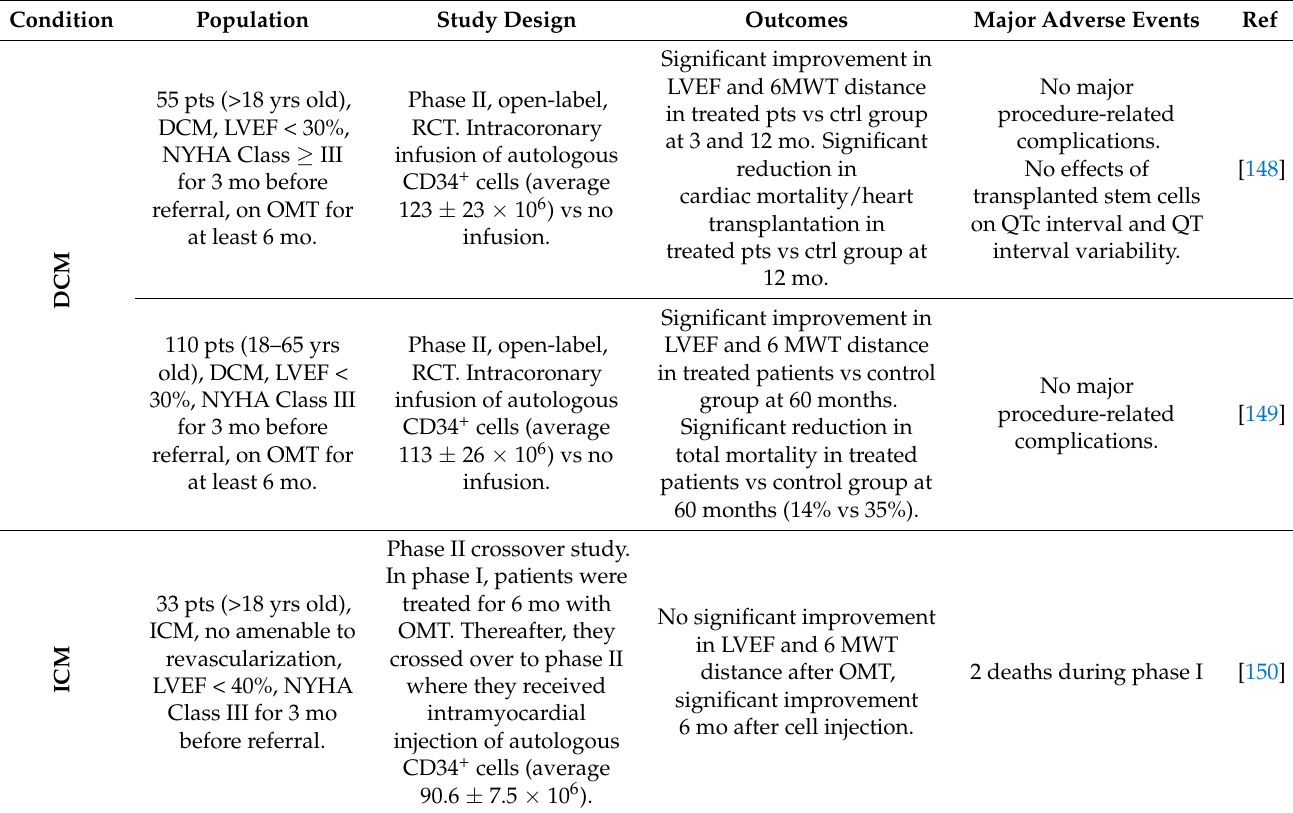
Table 2. Clinical trials on dilated and ischemic